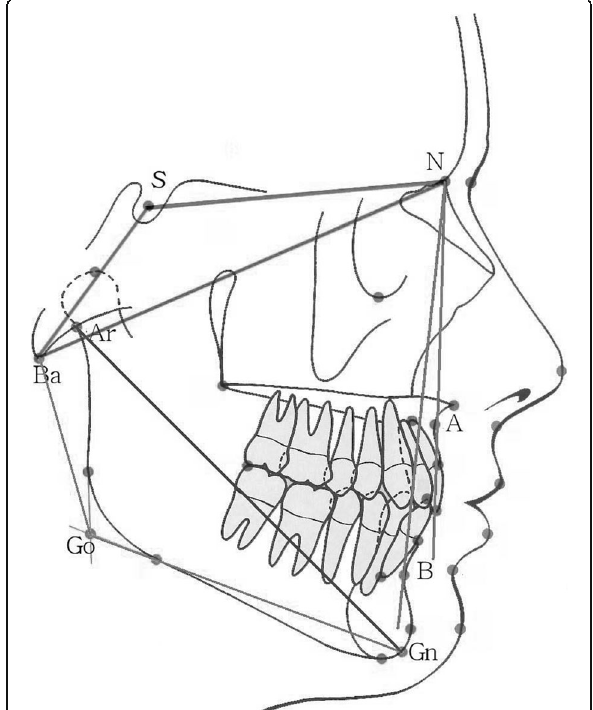
Fig. 1 Common cephalometric landmarks used in the cephalometric analysis